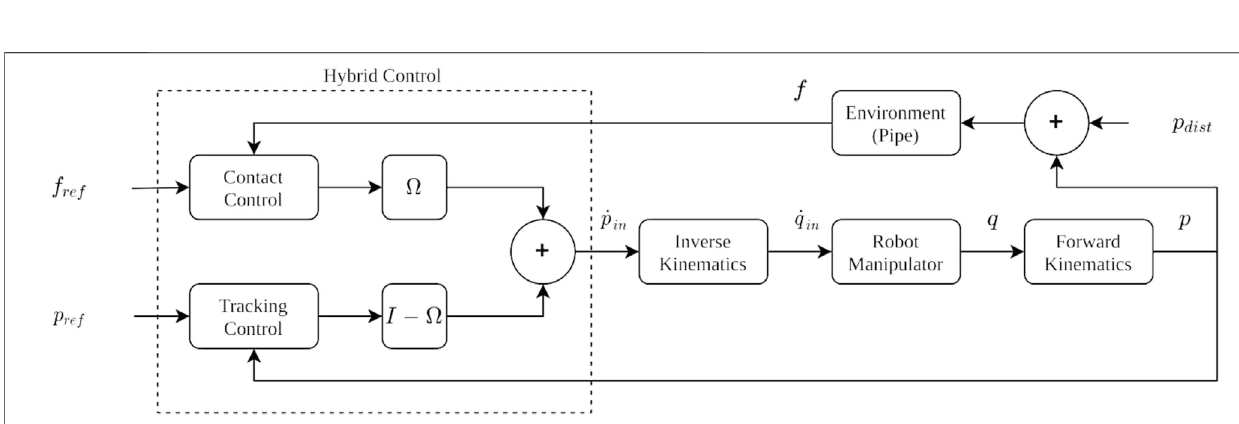
FIGURE 2 | Block diagram of the hybrid control